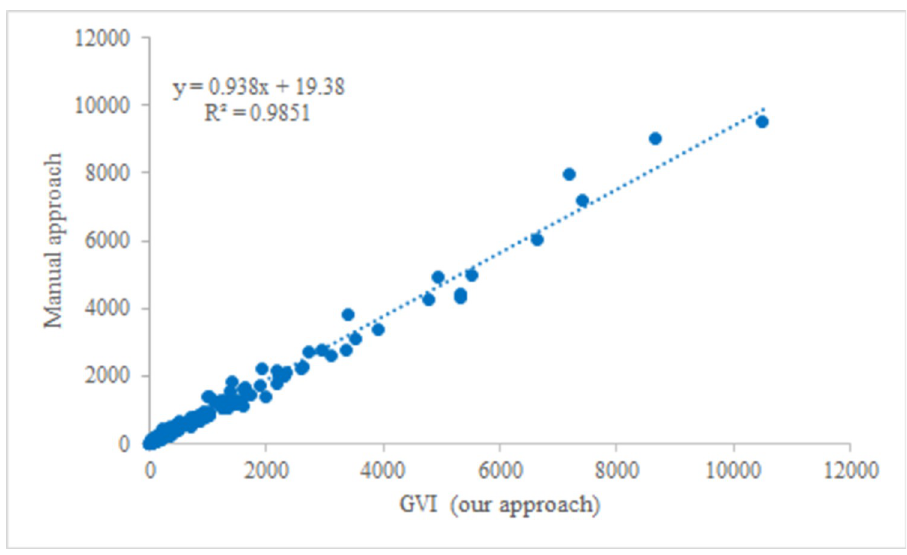
Fig 5. GVI results of two